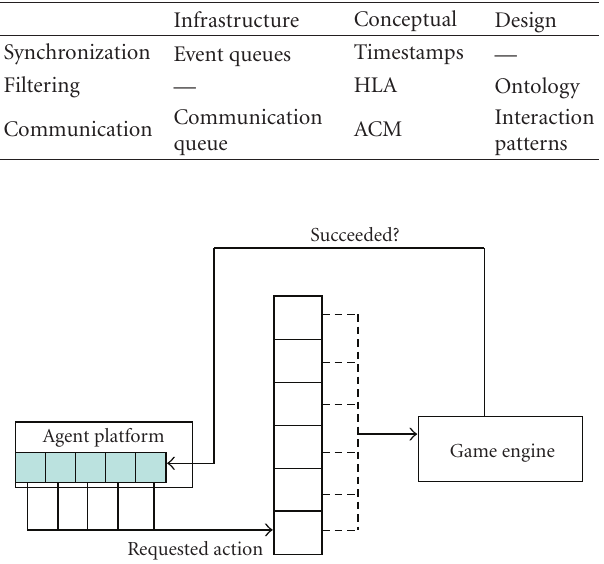
Figure 3: Event queues in the infrastructure allow both the agent platform and the game engine the flexibility to select events based on their own